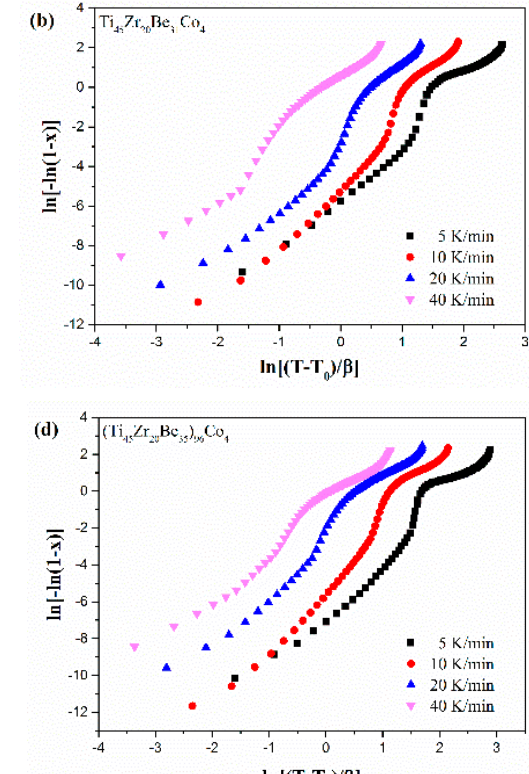
Table 7. The values of n derived from Figure 13.